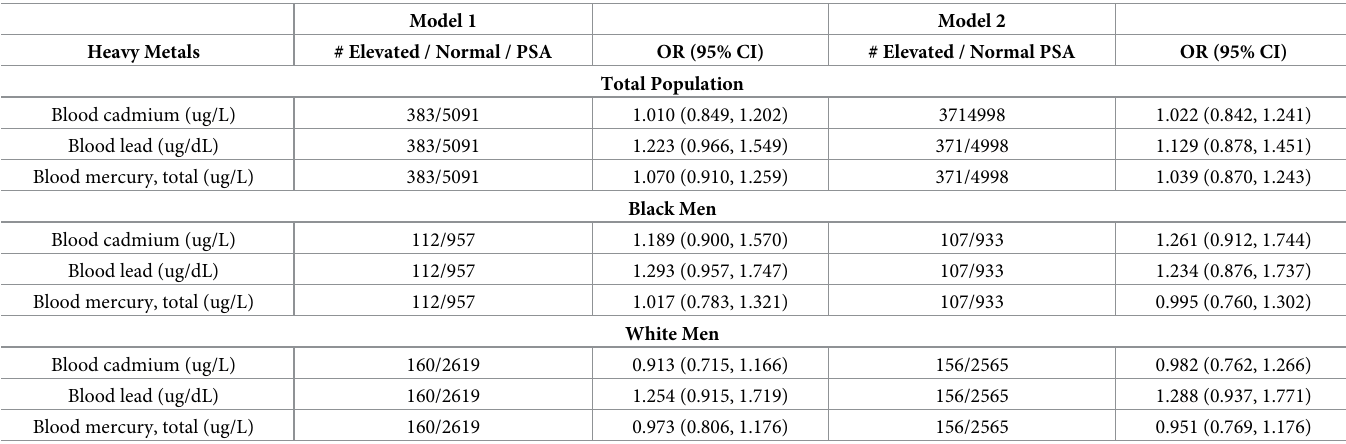
Table 4. Associations between blood levels of cadmium, lead, and total mercury and elevated serum PSA among 2003–2010 NHANES Men. Model